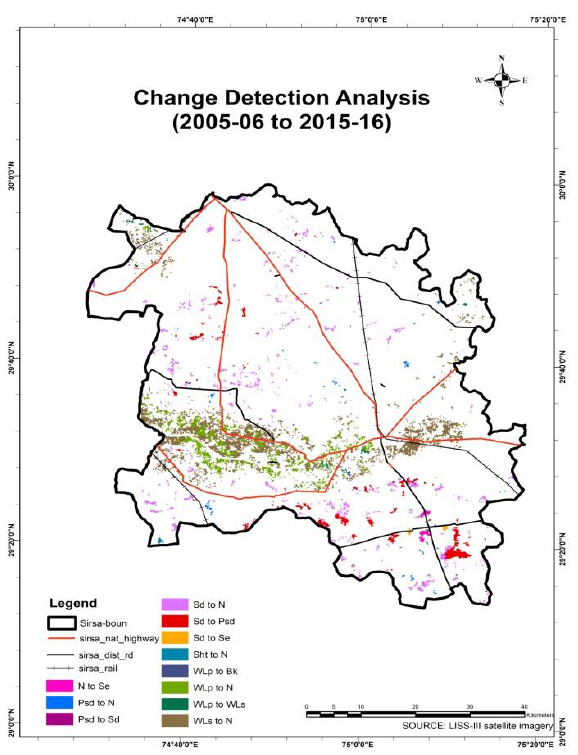
Figure 1. Map showing change in categories of degraded